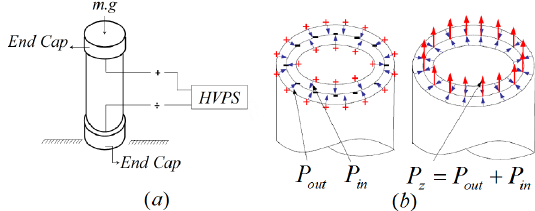
Figure 8: (a) The DEAP push actuator, (b) (i) Inner and outer pressure when electric field applied (ii) Resultant longitudinal